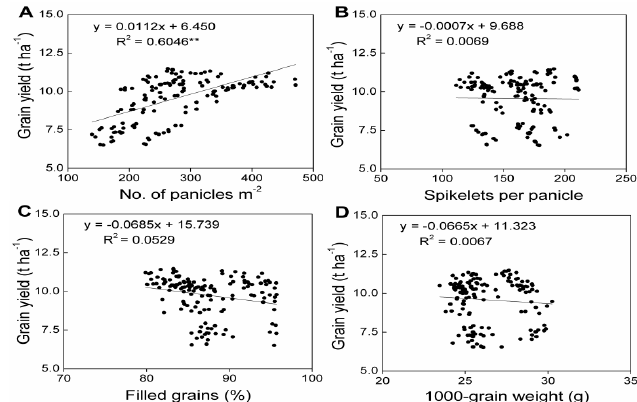
Figure 3. Relationship between grain yield and panicles per unit area ( A ), spikelets per panicle ( B ), filled grain percentage ( C ), and 1000-grain weight ( D ). Data were obtained from all the treatments at Shenyang and Anshan from 2015 to 2016. ** p ≤ 0.01.